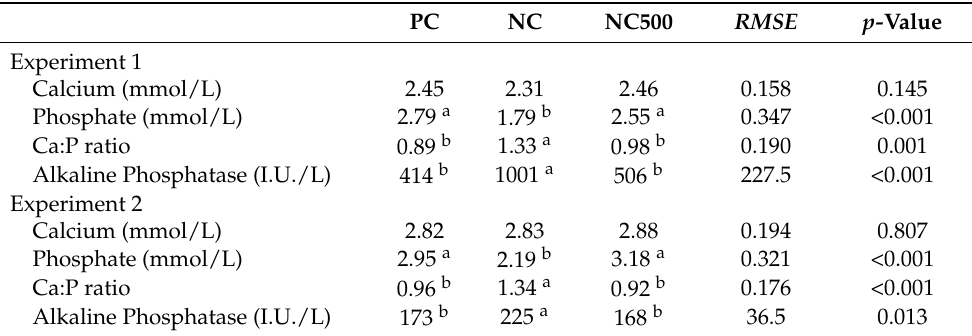
Table 5. Calcium (Ca) and phosphate (P) concentration and alkaline phosphatase activity in blood plasma of piglets fed a positive control diet (PC), a negative control diet (NC) with limiting levels of Ca and P, or an NC diet supplemented with 500 FTU/kg of phytase for 42 days 1 . PC NC